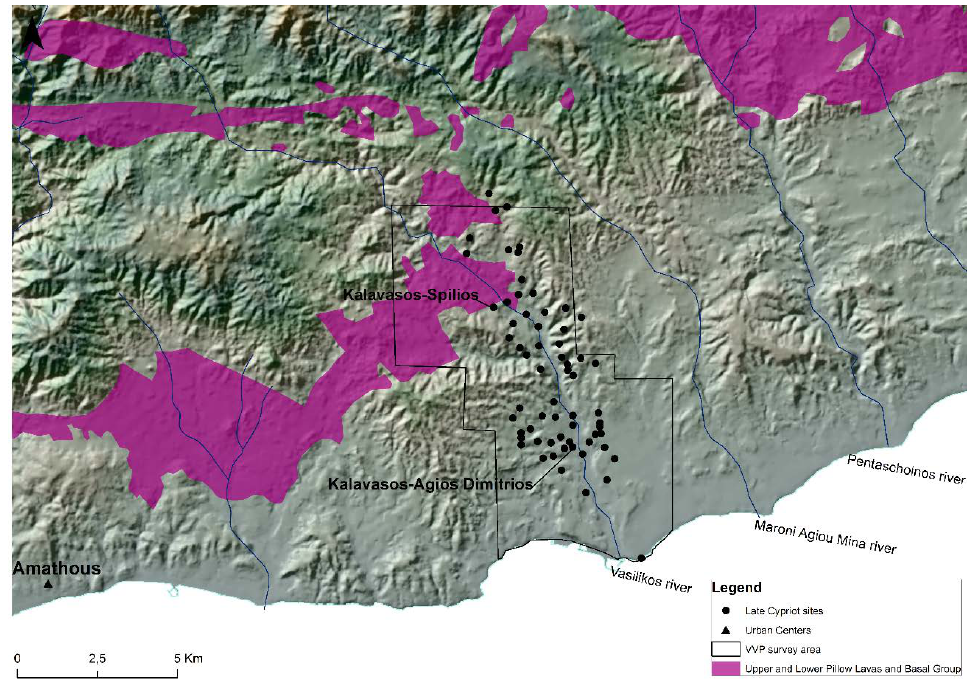
Figure 11. The Late Bronze Age centre of Kalavasos-Agios Dimitrios (and its settlement nucleation), west of our survey area. Digital data courtesy of the Geological Survey Department, Republic of Cyprus (Map by Niki Kyriakou).